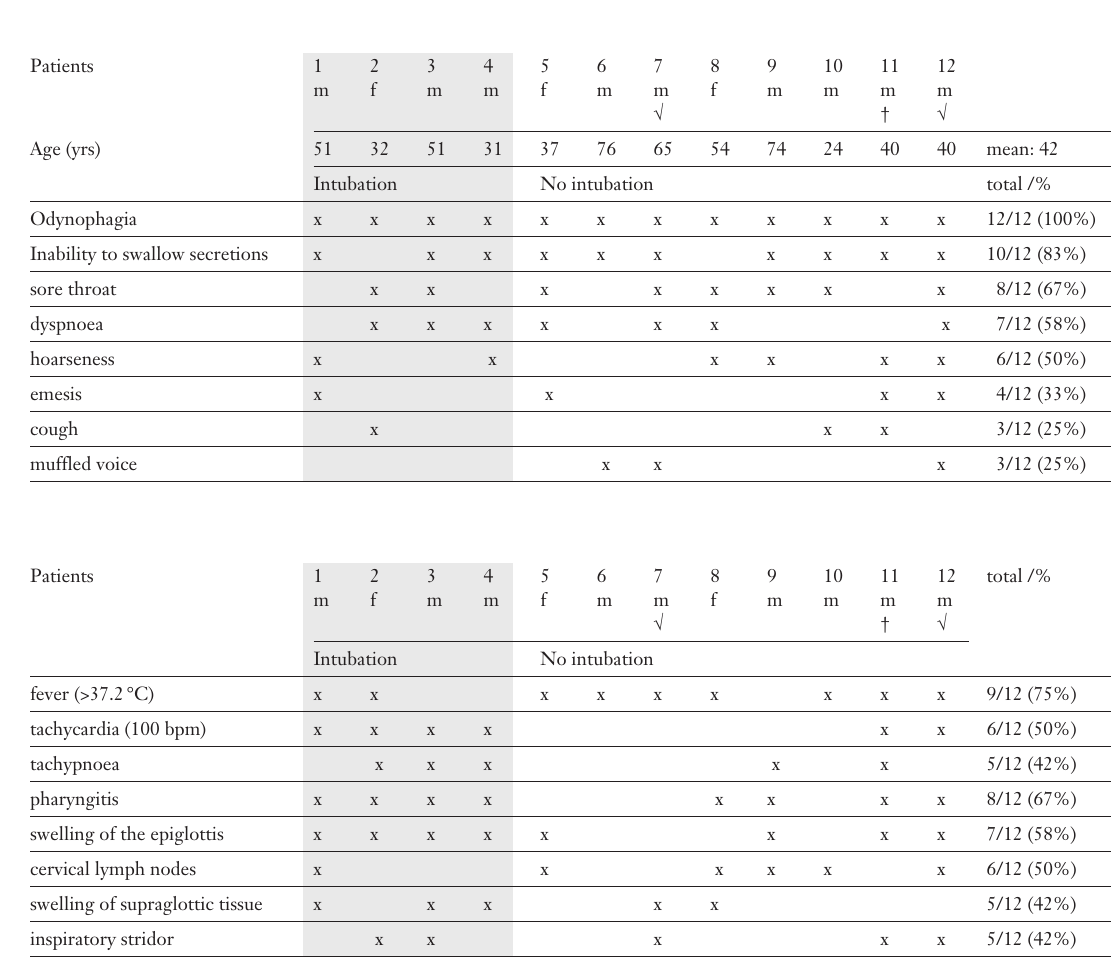
Symptoms of pa- tients with acute epiglottitis (n = 12). † patient who died, √ correct diagnosis when admitted.